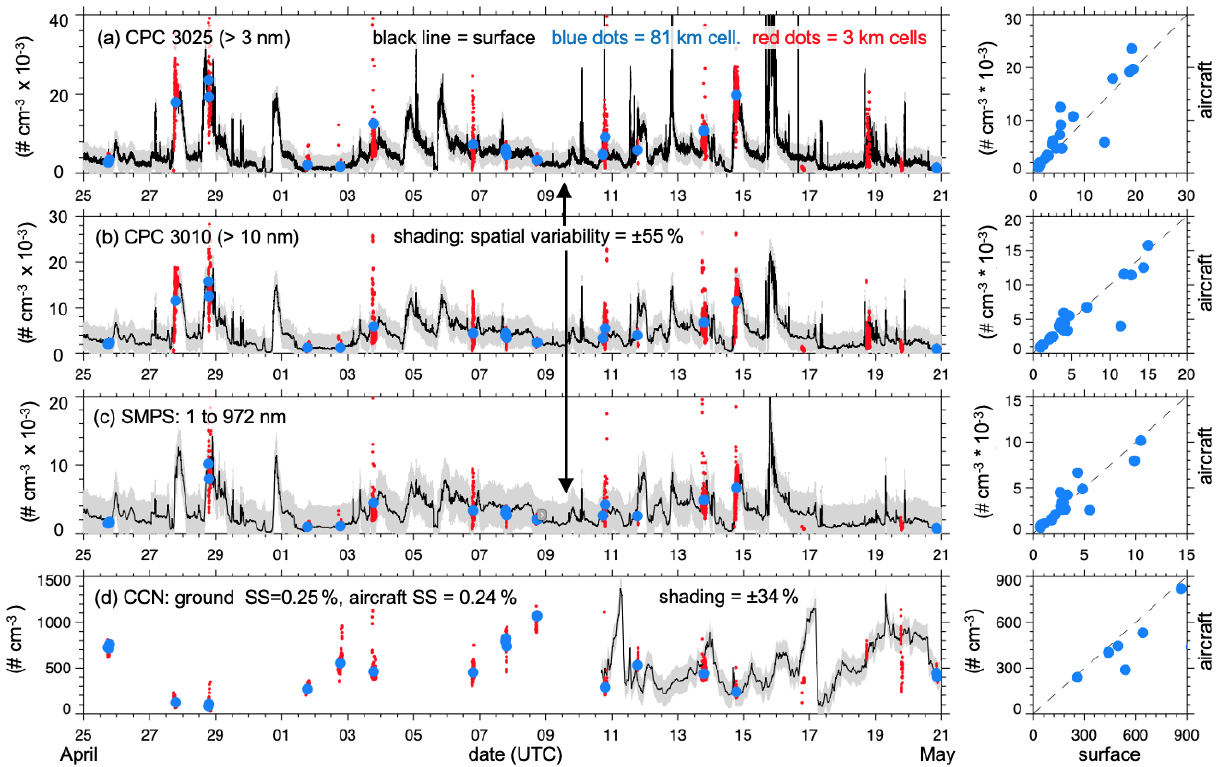
Figure 12. Measured (a) number concentration > 3nm, (b) number concentration > 10nm, (c) number concentration between 1 and 972nm, and (d) CCN concentration at the surface SGP site during IOP 1 (black lines), along with aircraft 81km cell averages within the boundary- layer (blue dots) and 3km cell averages (red dots) with the 81km cell over the SGP site. The right-hand-side panels compare coincident-in- time surface and aircraft